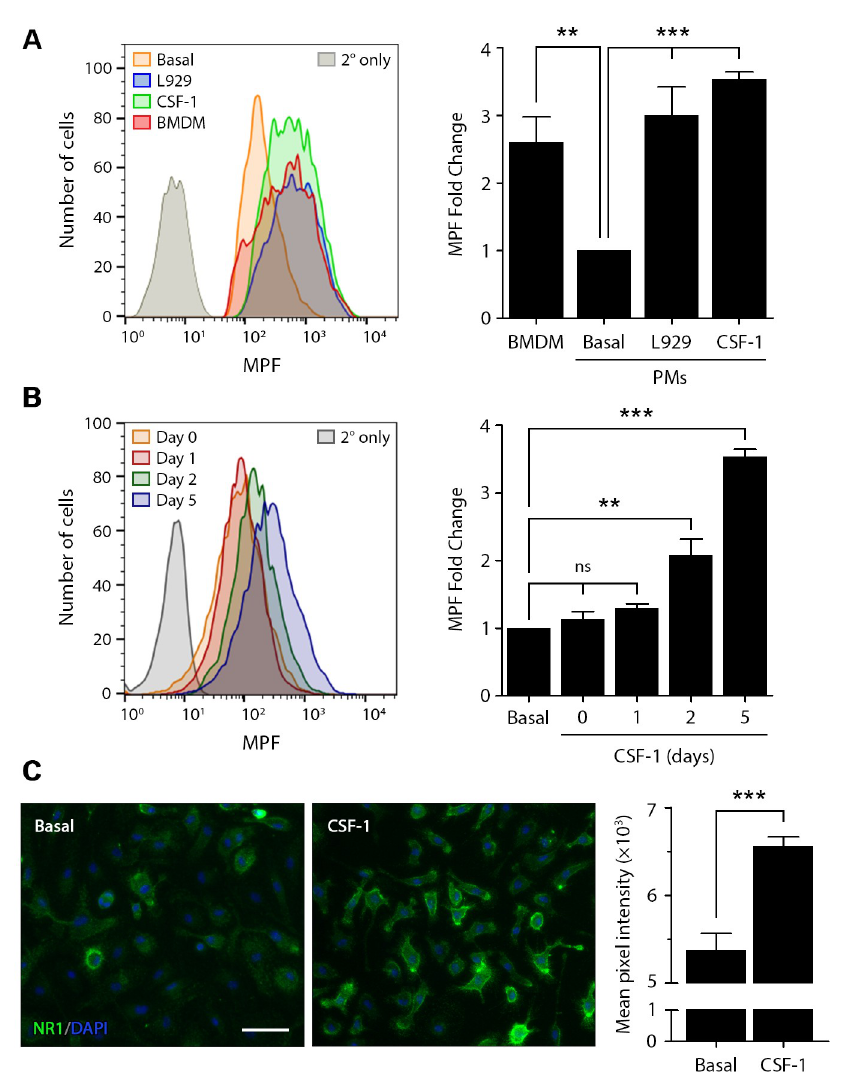
Fig 5. CSF-1 regulates cell surface NMDA-R in macrophages. Cell surface NMDA-R was labeled in BMDMs and PMs using NR1 subunit-specific primary antibody and Alexa Fluor 647-conjugated secondary antibody. (A) Representative flow cytometry histograms are shown for BMDMs, quiescent PMs (basal), PMs treated with L929 cell- conditioned medium for 5 days (L929), and PMs treated with CSF-1 (10 ng/mL) for 5 days. As a control, PMs were treated with secondary antibody alone (2˚ only). The bar graph (right panel) shows the fold increase in the MPF compared with quiescent PMs (no exposure to L929 cell conditioned medium or CSF-1) (mean ± SEM, n = 4; one-way ANOVA with Bonferroni post-hoc test, �� p < 0.01, ��� p < 0.001). (B) Representative NMDA-R NR1 subunit flow cytometry histograms are shown for PMs treated with CSF-1 (10 ng/mL) for increasing periods of time (0, 1, 2, and 5 days). The fold increase in the MPF compared to untreated cells is presented (mean ± SEM, n = 4; one-way ANOVA with Bonferroni post-hoc test, �� p < 0.01, ��� p < 0.001, ns = not significant). (C) IF microscopy images showing NMDA-R NR1 subunit in fixed, non-permeabilized PMs cultured in basal medium (left) or in CSF-1-supplemented medium (right) for 2 days. Images are representative of 3 independent experiments (scale bar, 10 μ m). The bar graph shows the quantification of mean pixel intensity as measured in 14 independent fields of view in three separate slides (mean ± SEM, unpaired t test, ��� p < 0.001). tPA and α M neutralize more than one TLR, including TLRs at the cell surface and within 2 endosomes, our results support a model in which regulation of TLR activity occurs